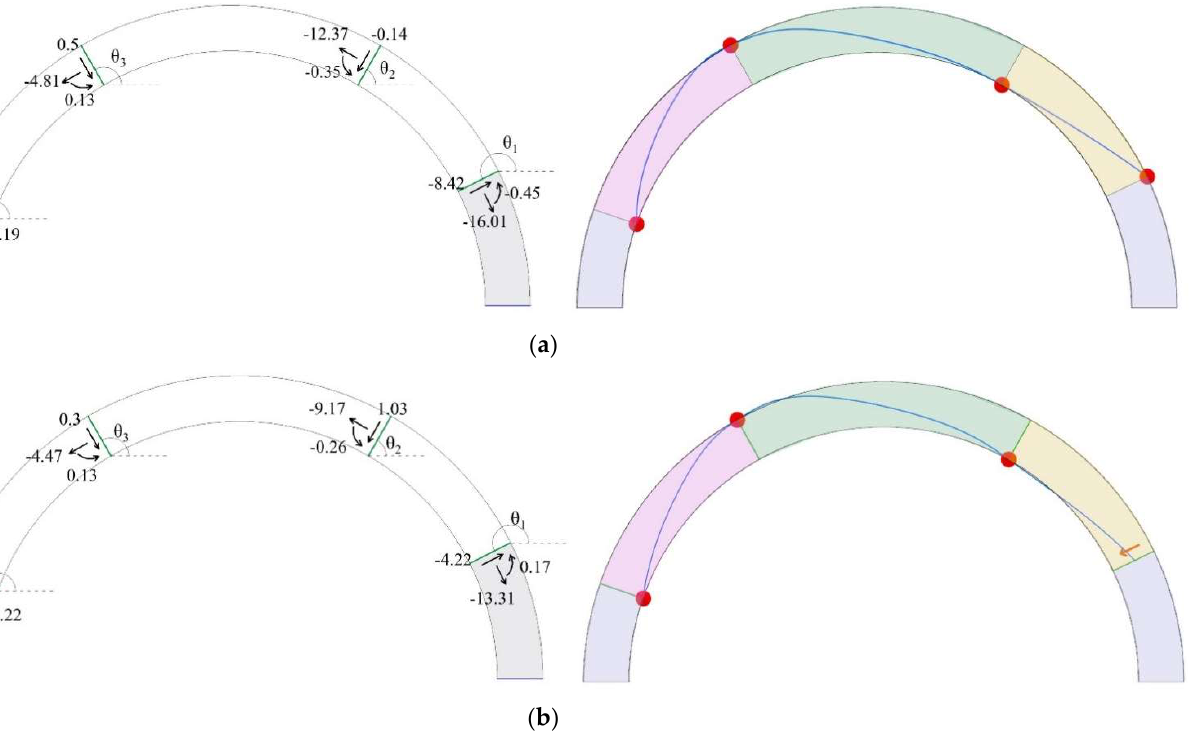
Figure 13. Internal forces (in Newtons) and moments (in Newton-meters) as well as the thrust line obtained by Equation (8) for the simple example of Figure 11 with peripheral joints, when the friction angle is: ( a ) 35° and ( b ) 17.6°.